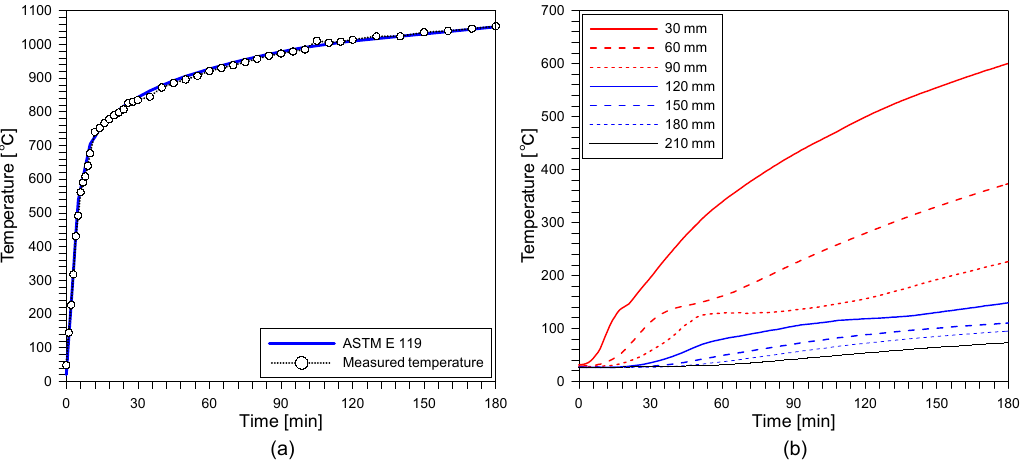
Figure 5. Temperature during ASTM E 119 standard fire: ( a ) ASTM E 119 standard fire curve and measured temperature in the furnace chamber, and ( b ) temperature within concrete slabs measured by K-type thermocouples embedded in the concrete slab specimen.